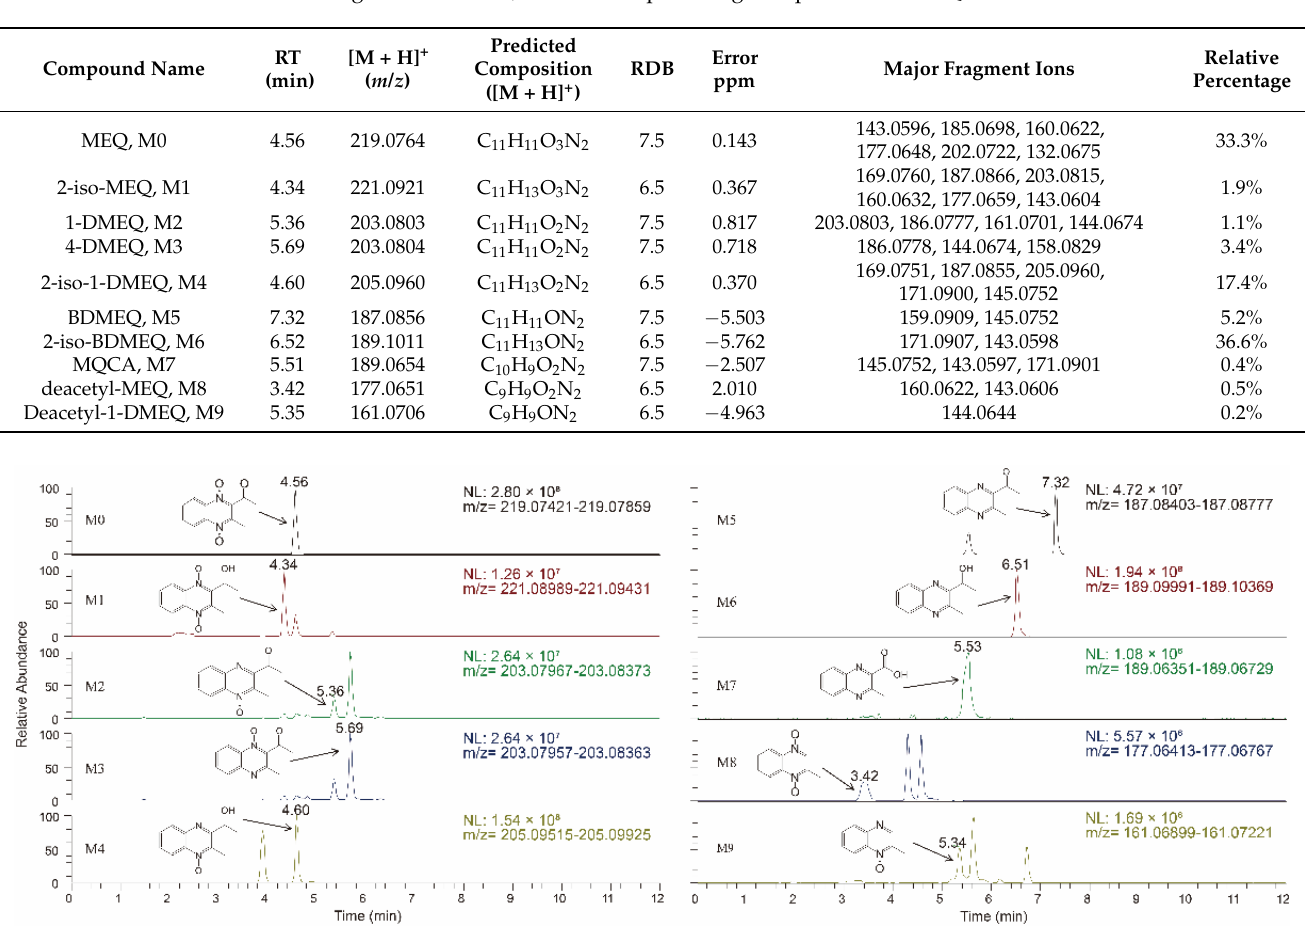
Table 1. Retention times (RT), predicted elemental compositions ([M + H] + ), mass errors, major fragmentation ions, and relative percentages of protonated MEQ and metabolites.